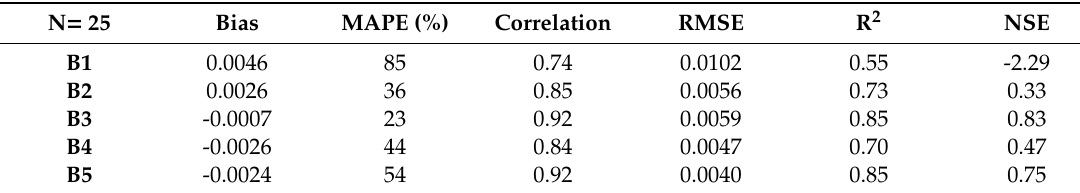
Table 4. Same as in Table 3 but for the Sen2Cor